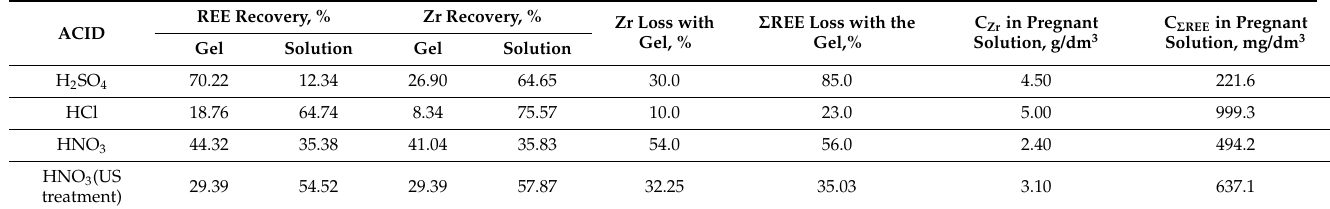
Table 8. Recovery of Zr and REE and losses with silicate gel under various leaching conditions and their concentrations in the pregnant solutions after the gel-like phase